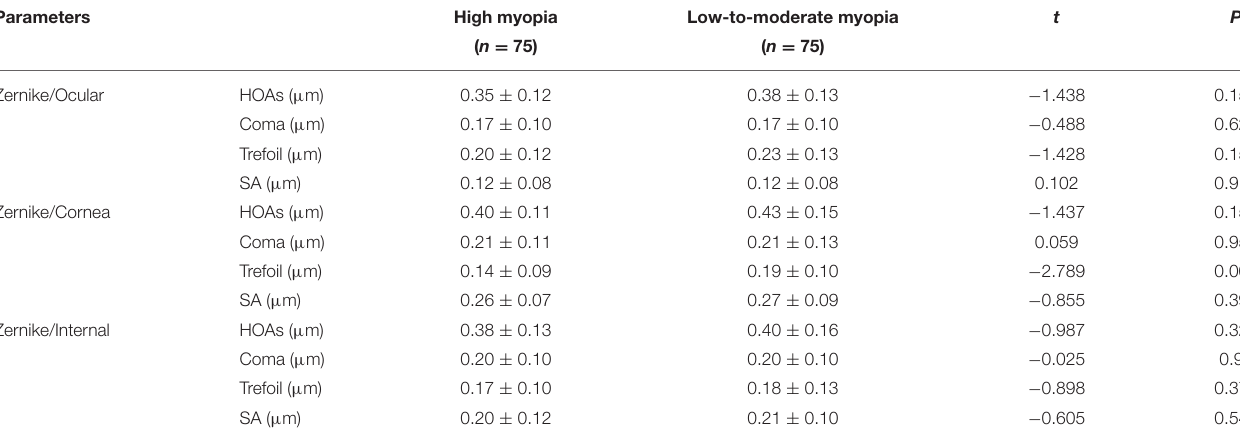
TABLE 2 | Participant OPD-scan data (zone: 6mm, n = 150). Parameters High myopia Low-to-moderate myopia